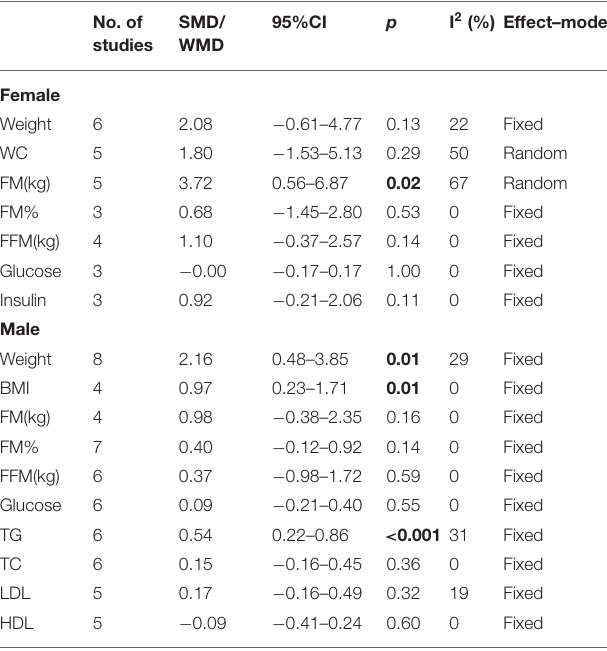
TABLE 4 | Physical and biochemical parameters of IF vs. non-intervention diet/CR in women and men.